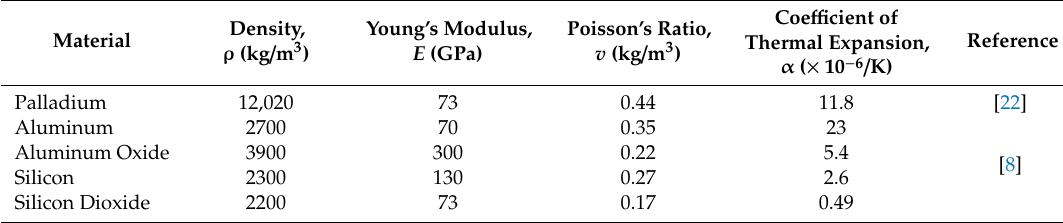
Table 1. Material properties specifications at T = 300